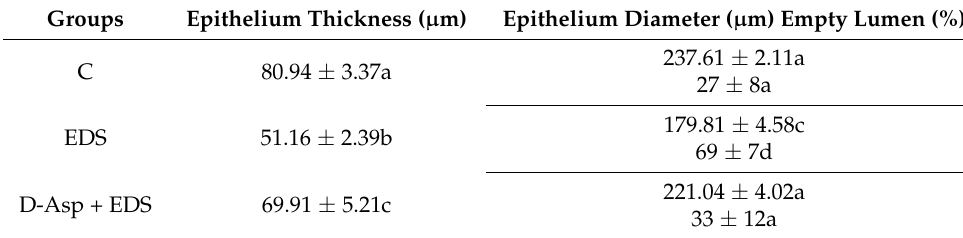
Table 1. Morphometric parameters evaluated in the rat